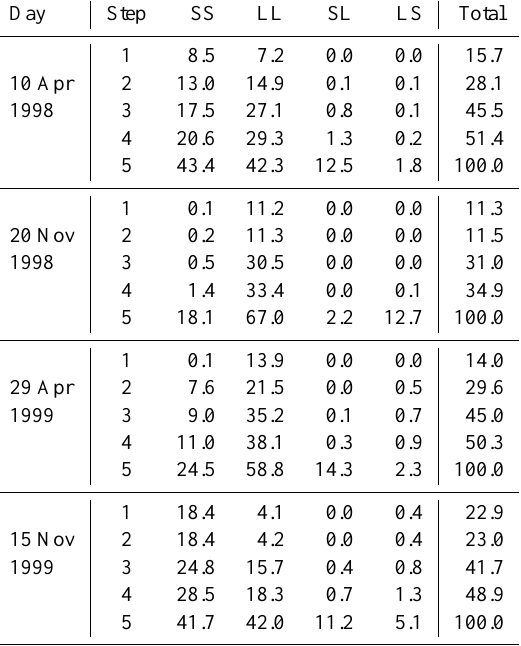
Table 4. Contingency table (in %) for the reconstructed snow-cover maps validated against four aggregated Landsat snow-cover images. Four cases are distinguished: SS, LL, SL and LS. The first (second) letter indicates the classification according to the presented algo- rithm (Landsat). “S” stands for snow and “L” for land. “Total” in- dicates the percentage of pixels classified after each step. Results refer to the Landsat domain (dashed line) shown in Fig. 1b.